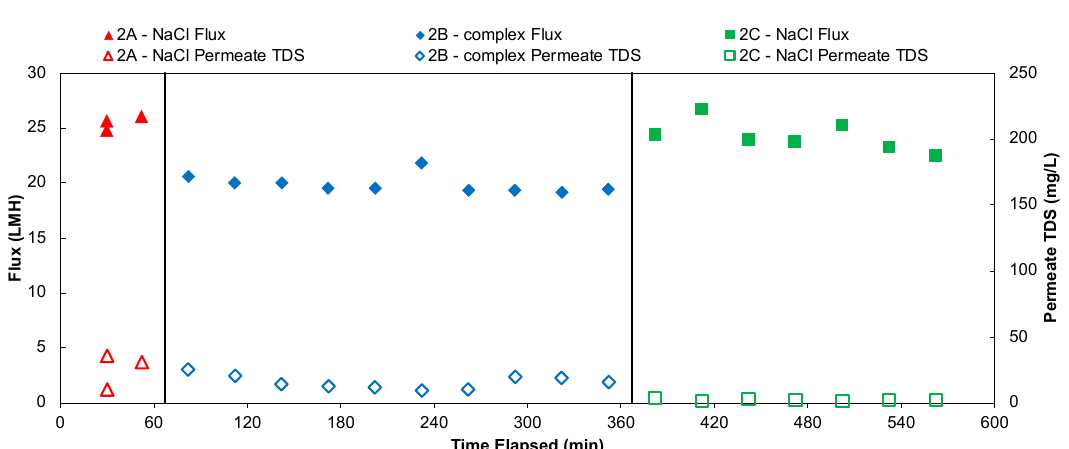
Figure 7. Water flux and permeate TDS of 3 continuous desalination experiments in the PVD system, with feed crossflow Reynolds number of 4800, feed water temperature of 85 °C and permeate vacuum of 0.85 bar. The red triangles and green squares represent data from experiments with 10 g/L NaCl feed solutions and the blue diamonds represent data from experiments with synthetic produced water (TDS = 10 g/L) feed solutions. The solid markers represent flux data and the empty markers represent permeate TDS data.